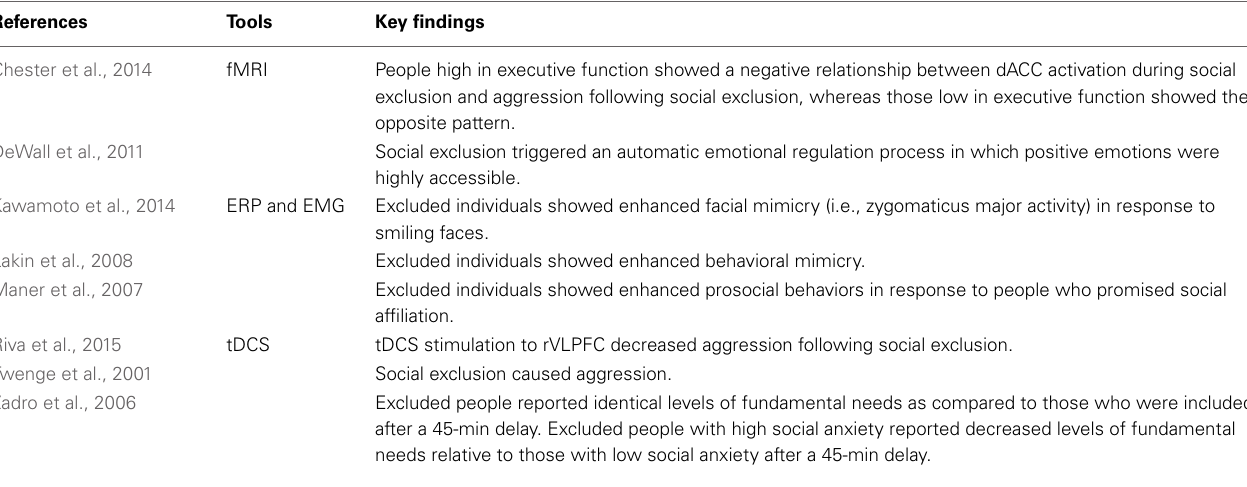
Table 2 | Key studies on interpersonal processes of social